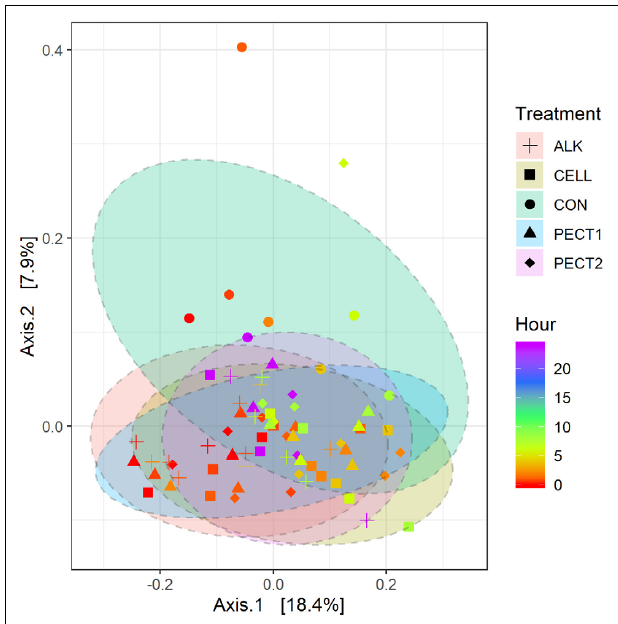
FIGURE 3 | Principal coordinate analysis (PCoA) plot generated based on an unweighted UniFrac matrix. Samples were grouped by shape and color representing the treatment and time point they belonged to, respectively: CON (sphere), ALK (plus), PECT1 (triangle), PECT2 (diamond), CELL (square); a red-green-purple scale was used to indicate the fermentation time (red and purple depict start and end of the fermentation period).